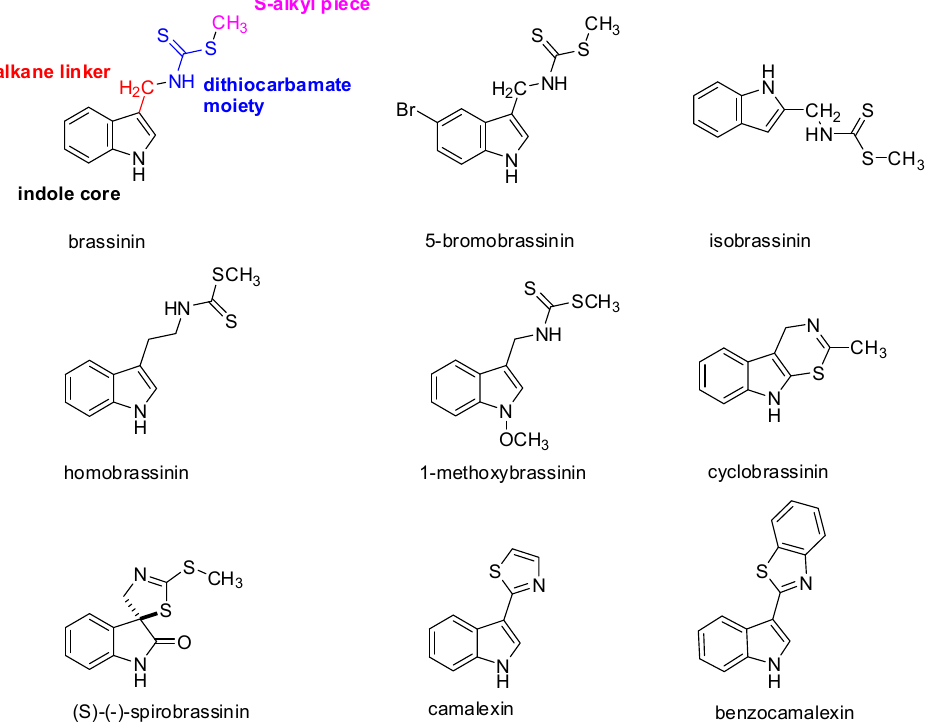
Figure 1. Molecular structures of the representative indole phytoalexins and their derivatives.